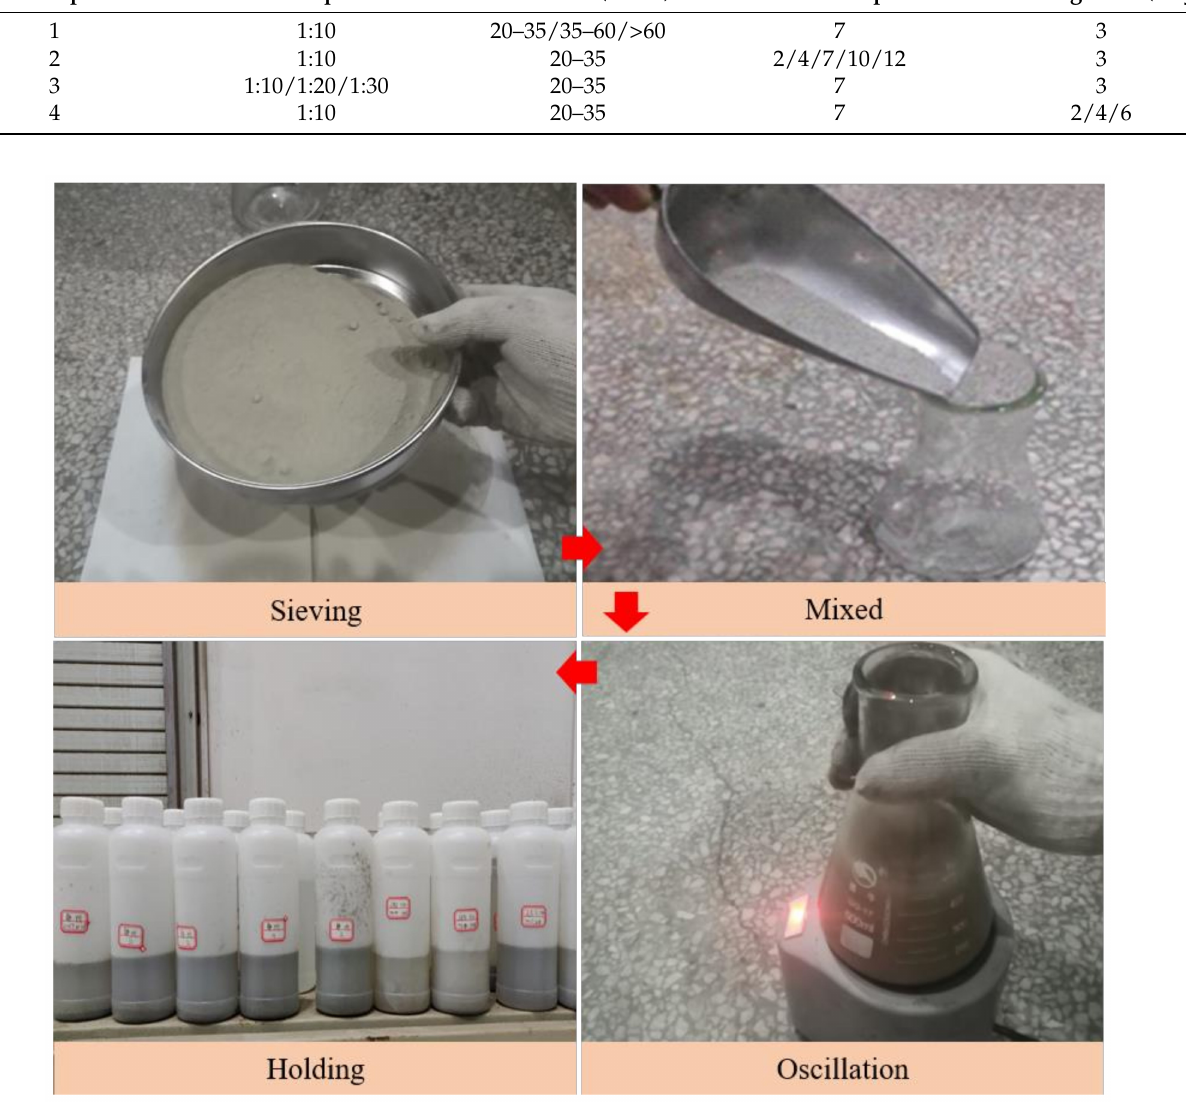
Figure 8. Static leaching test